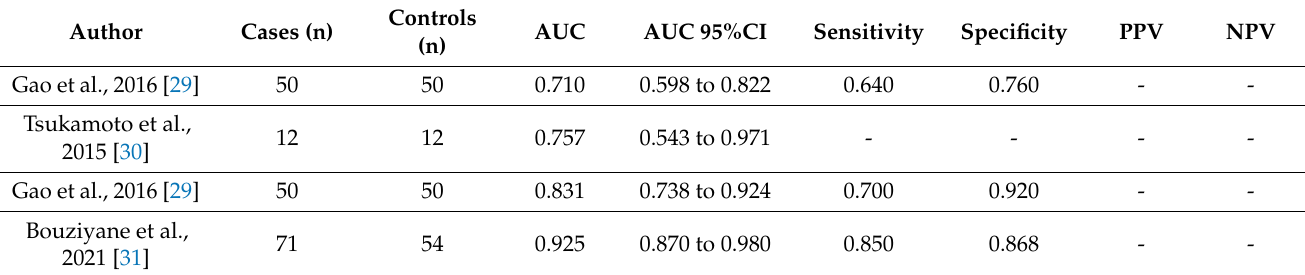
Table 2. Summary table of the performance of Micro-RNA 21.